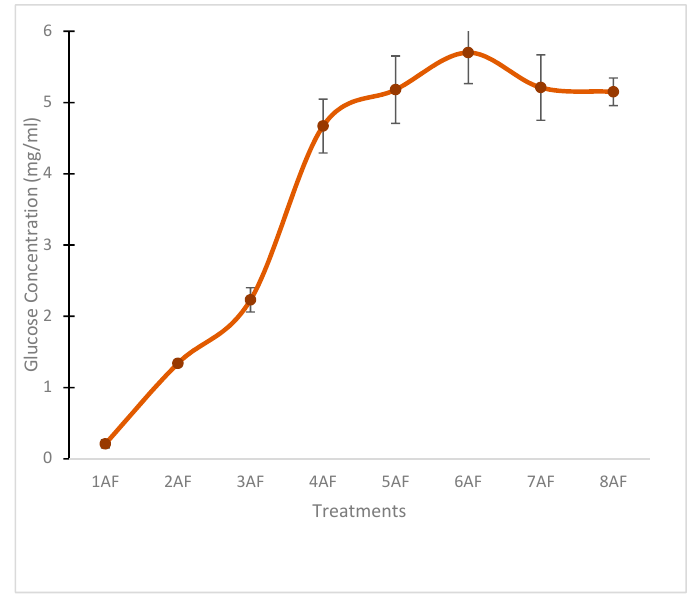
Figure 4. Determination of the optimum cellulosic fiber waste concentration that results in the highest production of glucose units after treatment with 40% HCl, followed by autoclaving. 1AF, 2AF, 3AF, 4AF, 5AF, 6AF, 7AF, and 8AF are 0.2, 1, 2, 3, 4, 5, 6, and 7% of the cellulosic waste, respectively.